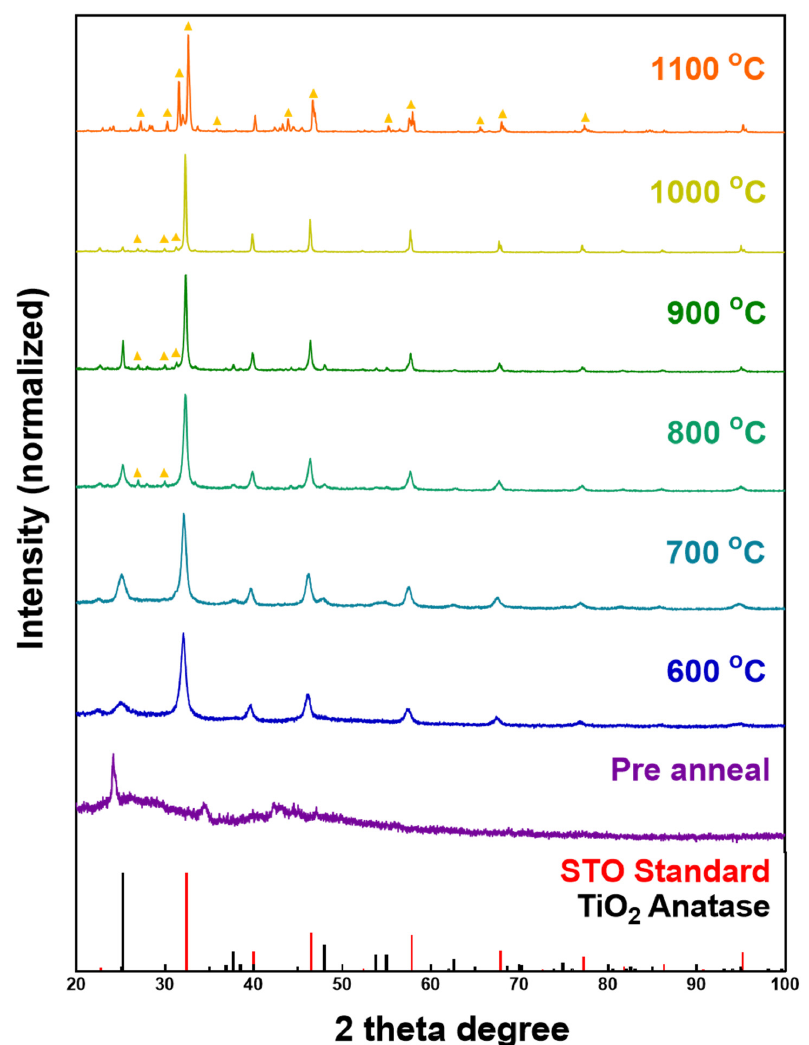
Figure 5. XRD patterns of a STO powder sample calcined from 600 °C to 1100 °C, in increments of 100 °C. The data on all samples were acquired after the acid wash, except for the pre-annealed sample. Samples are compared with standard anatase TiO 2 and STO patterns. Triangles associated with the 800 °C to 1100 °C samples indicate the presence of Sr 2 TiO 4 peaks.